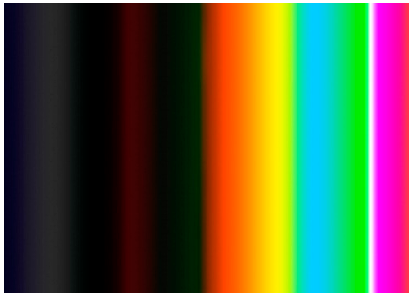
Figure A1. The color Figure 1. The color scale.